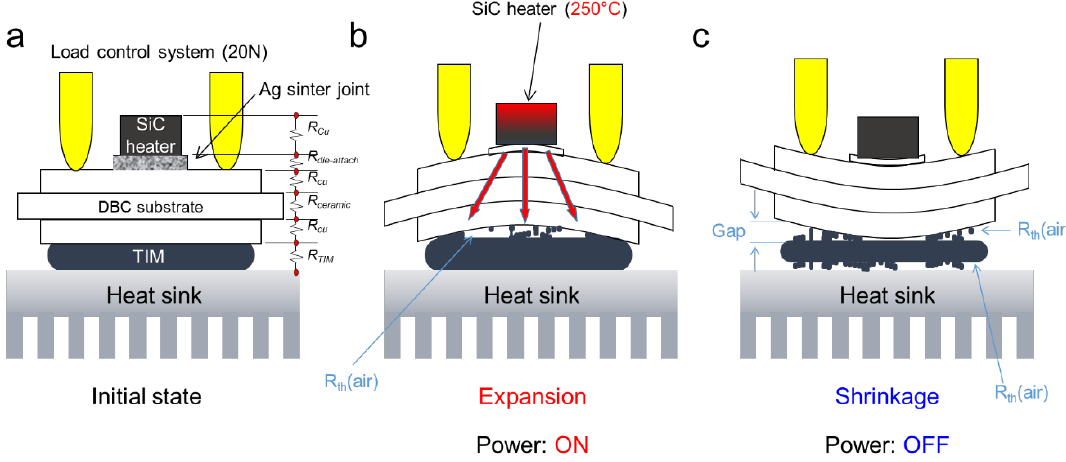
Figure 11. Schematic diagram of AlN temperature rise mechanism by mechanical behavior during power cycling test: ( a ) initial state ( b ) expansion ( c ) shrinkage.